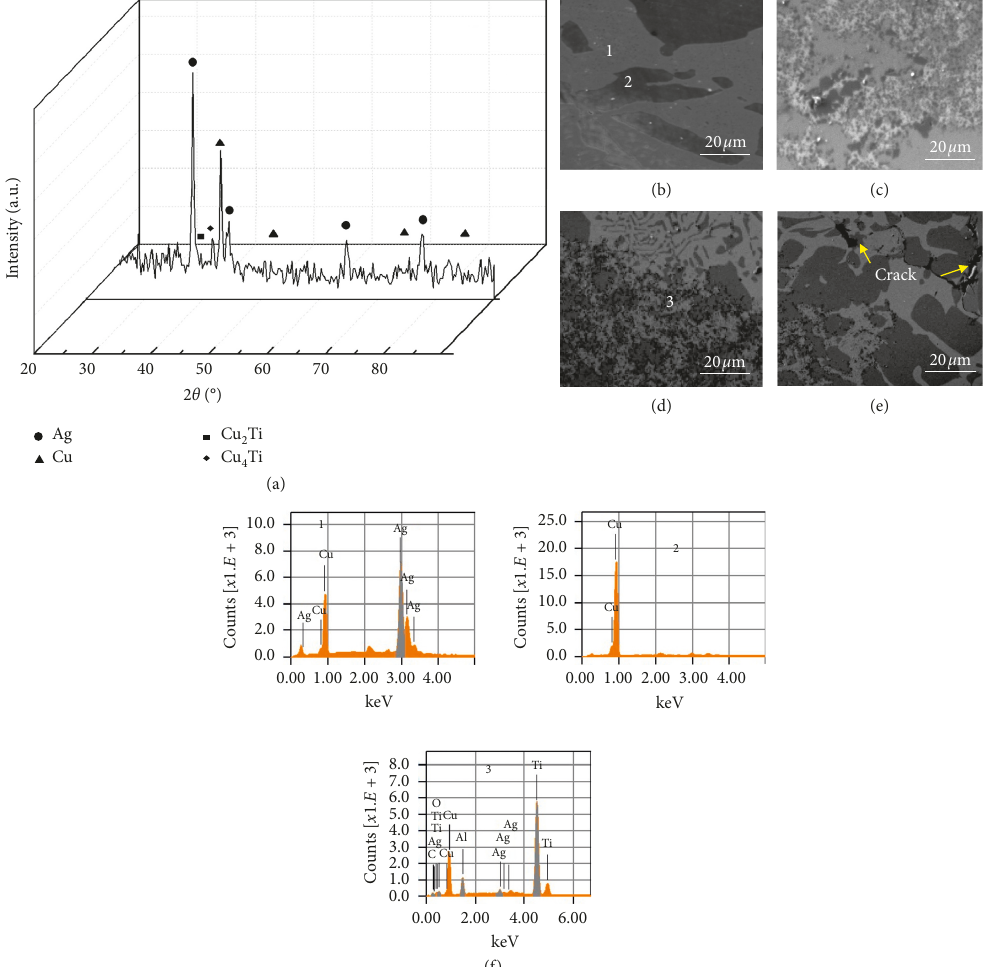
� 0.1wt.%) and (b–e) morphology of the Ag-Cu-Ti- x CeO 2 ( x